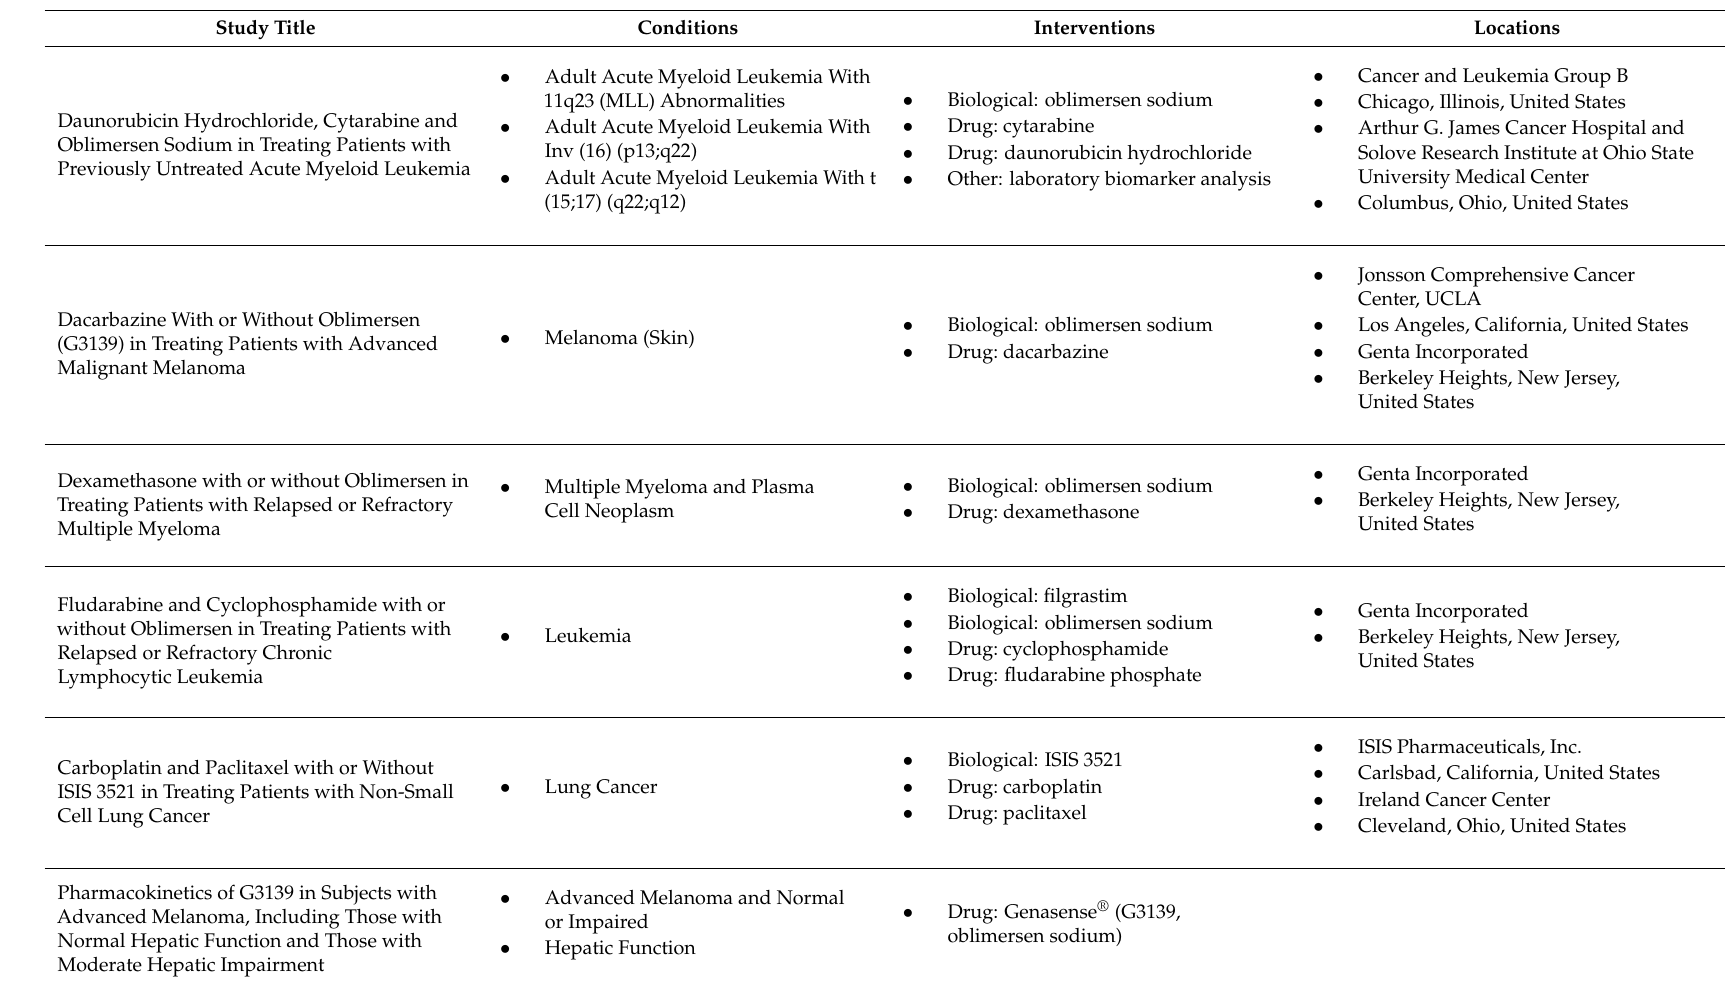
Table 4. Current clinical trials (phase III) for cancer patients that involve antisense